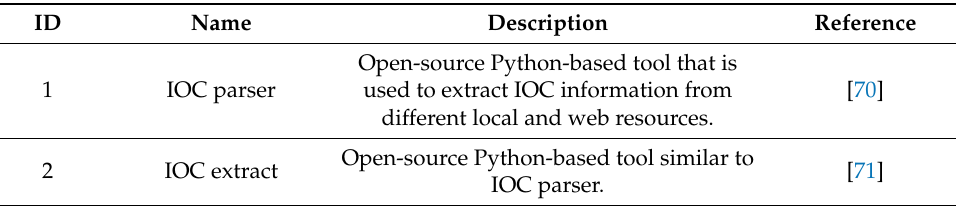
Table 16. Tools used for OSINT on indicator of compromise (IOC).